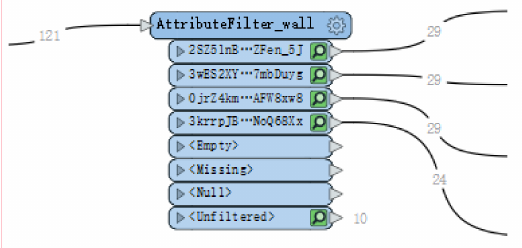
Figure 19. Filtering of walls in each